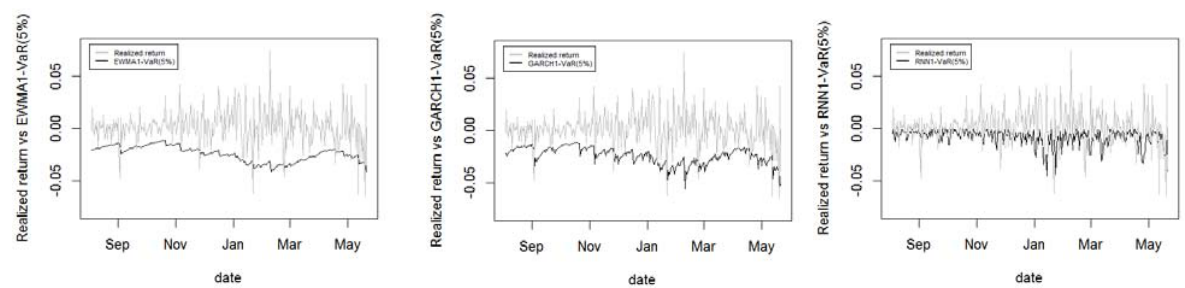
Figure 11 . Out of sample realized return vs 5 days ahead VaR(5%) of EWMA, GARCH and RNN model Figure 12. Out of sample realized return vs 10 days ahead VaR(5%) of EWMA, GARCH and RNN model